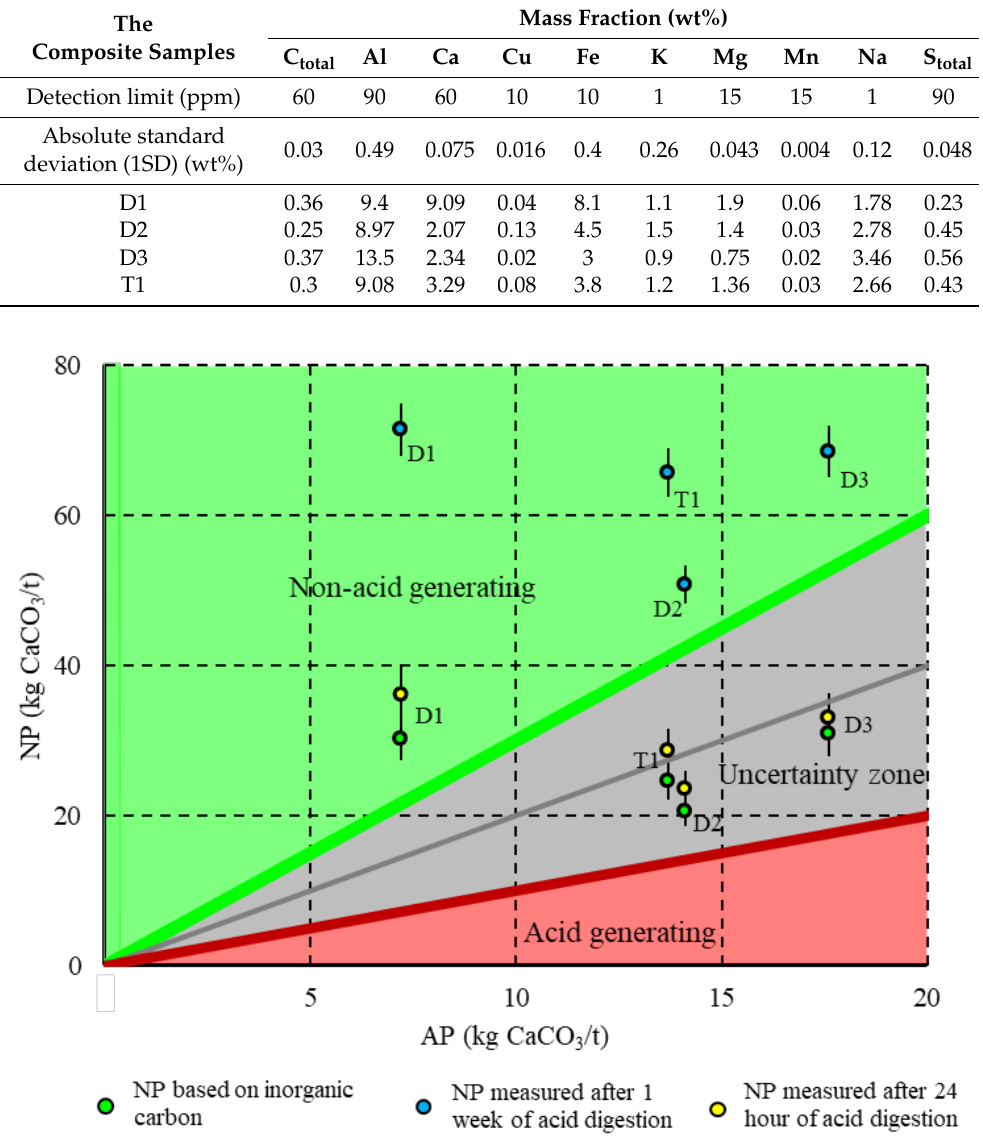
Table 3. Chemical analysis of the composite samples.